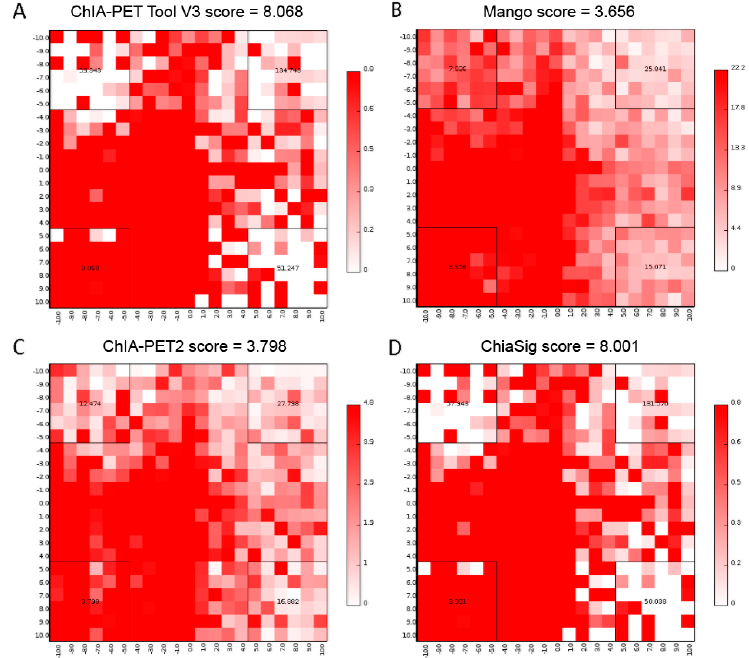
Figure 17. Aggregate Peak Analysis (APA) plots of significant interactions detected by different tools from human K562 cells. ( A ) APA plot of significant interactions detected by ChIA-PET Tool V3. ( B ) APA plot of significant interactions detected by Mango. ( C ) APA plot of significant interactions detected by ChIA-PET2. ( D ) APA plot of significant interactions detected by ChiaSig. Significant interactions are required at least 3 supportive PETs and FDR less than 0.05. Interaction matrices are built with BEDPE files of ChIA-PET data after removing duplicates. Interaction counts are summed for all pairs of loci in 25 kb bins.